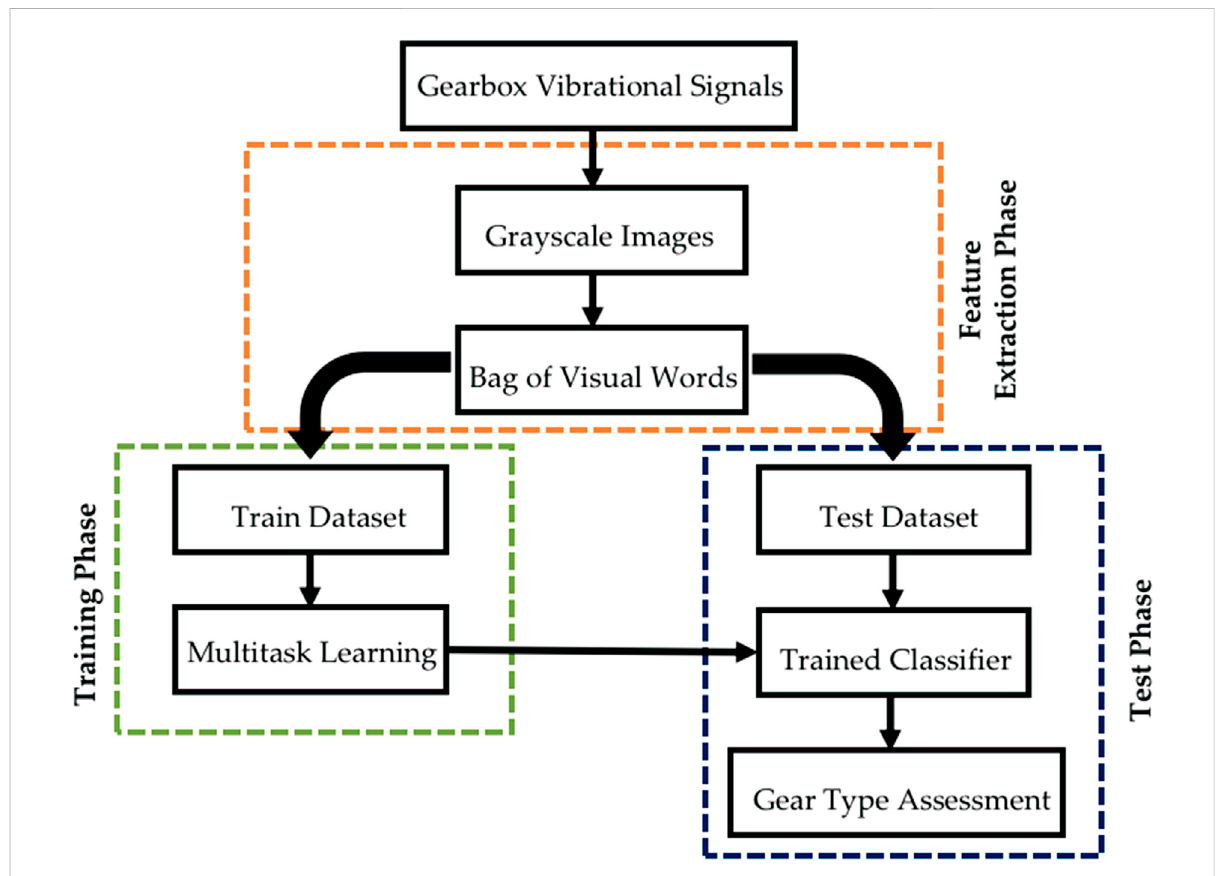
FIGURE 3 The proposed gearbox fault diagnosis model using multitask learning